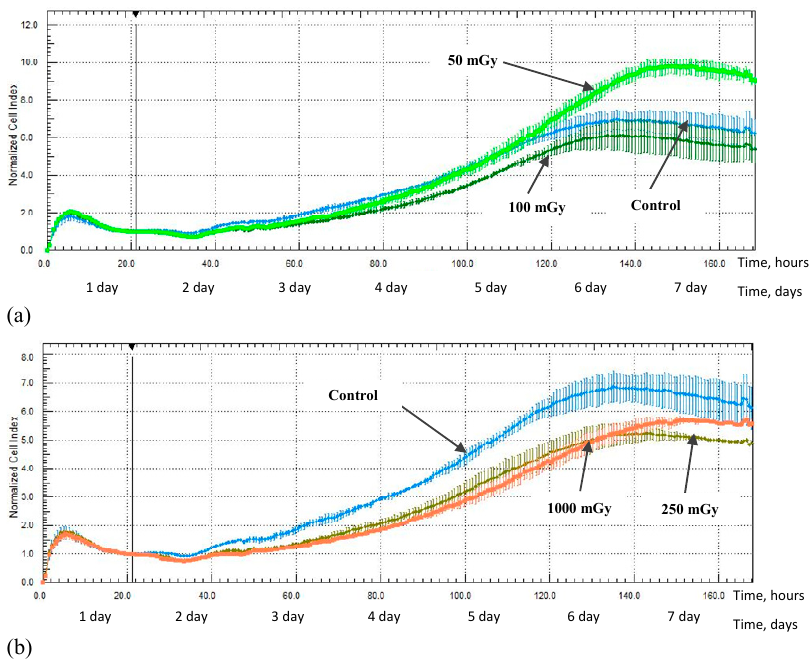
Figure 7. The proliferative activity of MSCs (n = 3) from 1 day after irradiation at doses of: ( a ) 50 mGy (light green) and 100 mGy (dark green), ( b ) 250 mGy (green) and 1000 mGy (orange). An increase in the proliferative activity of the MSCs was also noted in the study from 9 day after irradiation at a low dose of 50 mGy; an increase in the NCI value was noted up to 160 h after irradiation—7.4 ± 0.77 ( p < 0.05)—compared with the non-irradiated control group, 4.3 ± 0.53. At the same time, the intensity of the prolifera- tive activity of the MSCs which were irradiated at doses of 100, 250, and 1000 mGy has remained comparable to the non-irradiated control group (Figure 8).